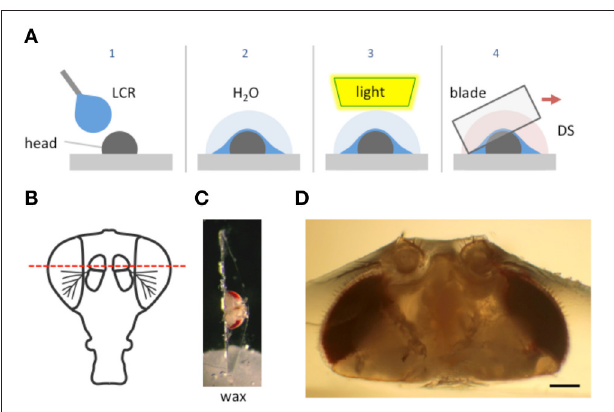
FIGURE 1 | Schematic of the goggatomy procedure. (A) Sequence of steps illustrated for a Drosophila head (read left to right). The gray rectangle represents the surface of a plastic petri dish. (B) Approximate level of section to produce intact JOs. (C) Goggatomized head in chip of LCR inserted into wax. (D) Higher powered view of a different sectioned head. Scale bar 100 µ m.